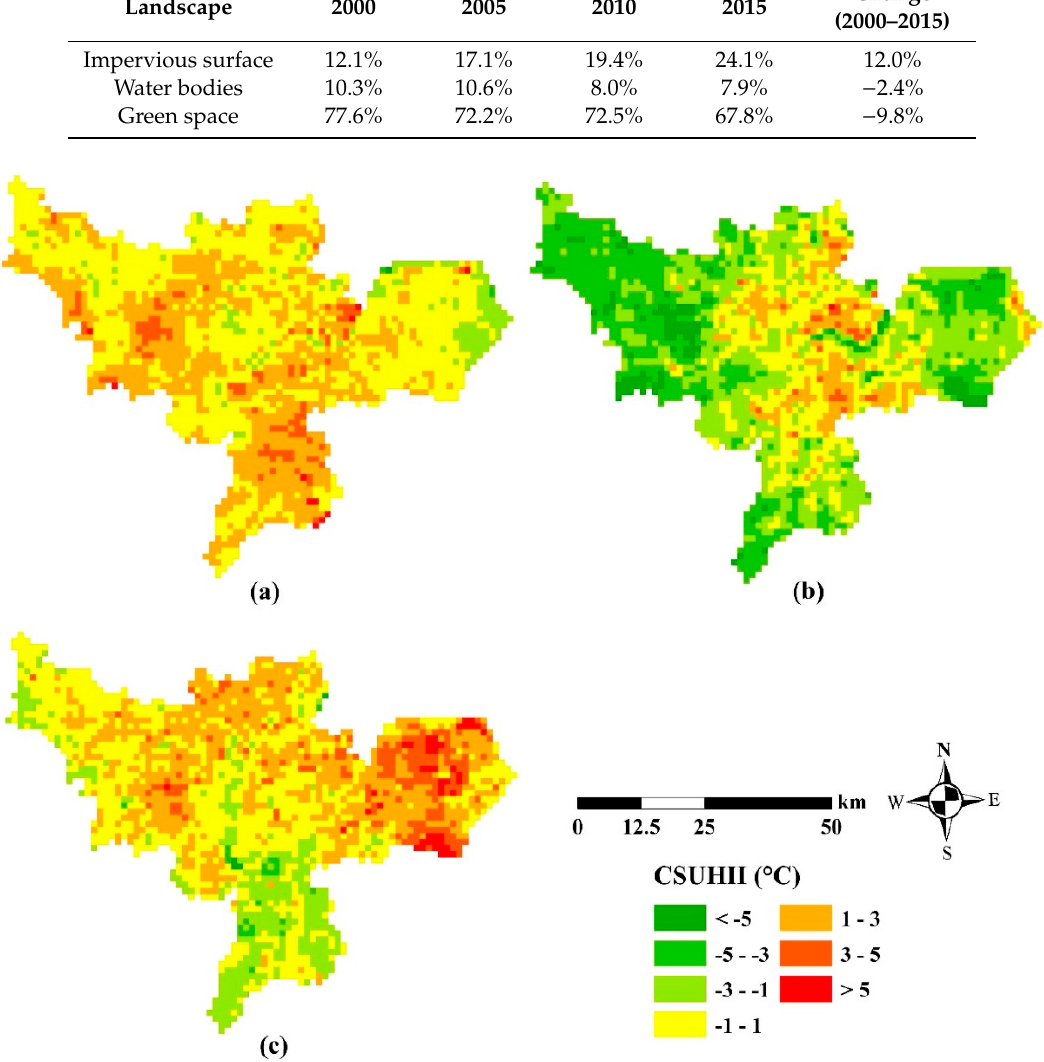
Figure 7. CSUHII in the HMA: ( a ) 2000 – 2005; ( b ) 2005 – 2010; ( c ) 2010 – 2015.